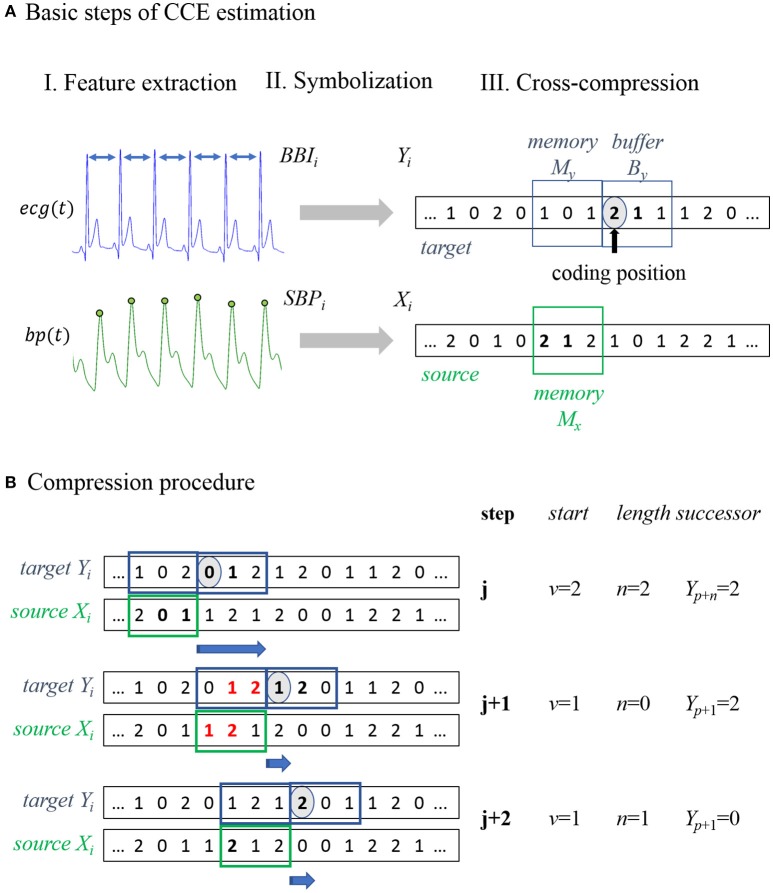
Schematic illustration of cross-compression entropy (CCE) estimation. (A) Overview of the three basic steps to calculate CCE. I. Feature extraction: Beat-to-beat intervals BBI and systolic blood pressure SBP were extracted from the recorded signals (ecg, electrocardiogram; bp, blood pressure). II. Symbolization: Time series were transformed to symbol series Xi and Yi. III. Cross-compression: Symbols of Yi in the target window are encoded using the symbols of Xi in the source window. (B) Compression procedure of example symbol series: in step j, a substring [0;1] in the target buffer YB = [0;1;2] occurs in the source memory XM = [2;0;1] beginning at second place (v = 1) with a length of two symbols (n = 2). Redundant symbols (written in bold) can be skipped, storing start v, length n, and the next symbol Y(n+p). In step j+1, a target substring YB = [1;2;0] of two symbols [1;2] occurs in the source memory XM = [1;2;1]. Because a string of the same length that matches buffer symbols, is included in the target memory, compression is not enhanced by considering the source. Therefore, the redundant strings are ignored (bold and red symbols) and the next symbol stored is Y(p+1). In the last step (j+2), no string with n > 1 was found and all windows were shifted forth in time by one sample Y(p+1).